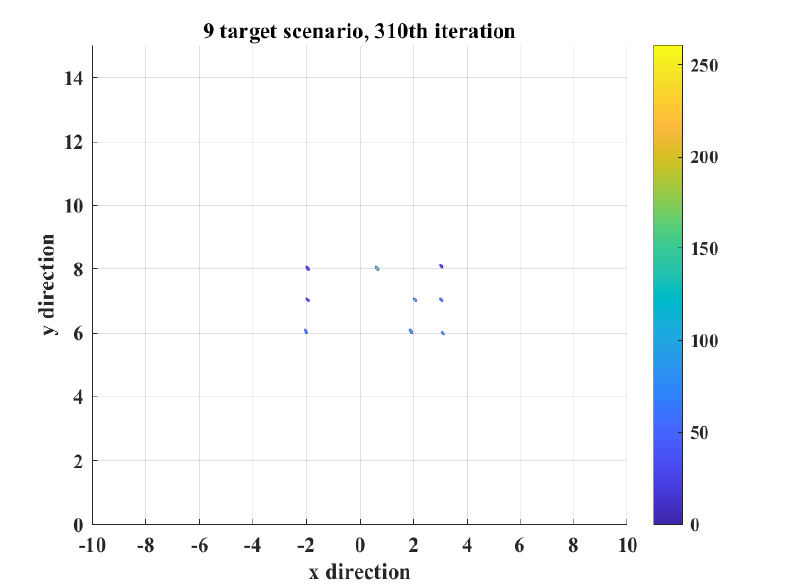
Figure 16. Surviving particles of the proposed algorithm at the end of 310th iteration for the same scenario as in Figure 13. The color scale indicates the mass of the